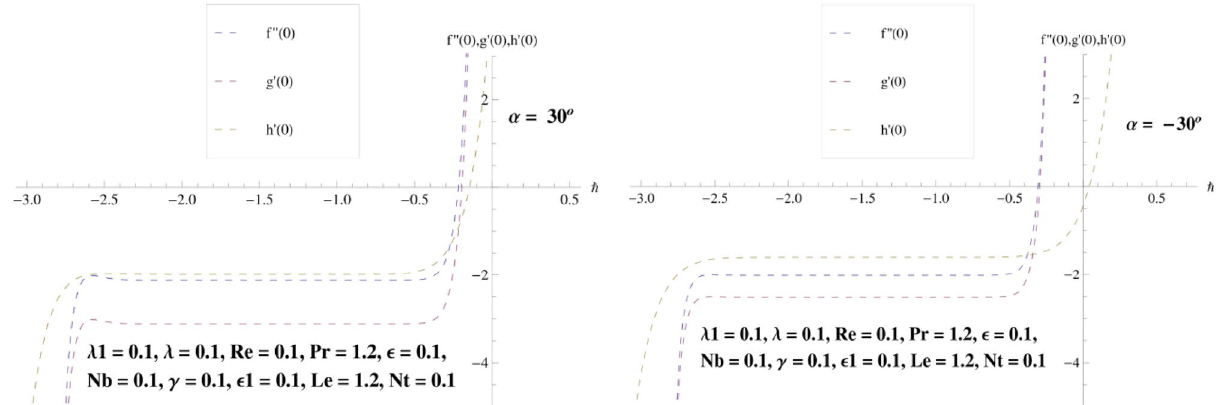
Figure 2. Convergence for f (η) , g (η) and h (η) in case of convergent/divergent